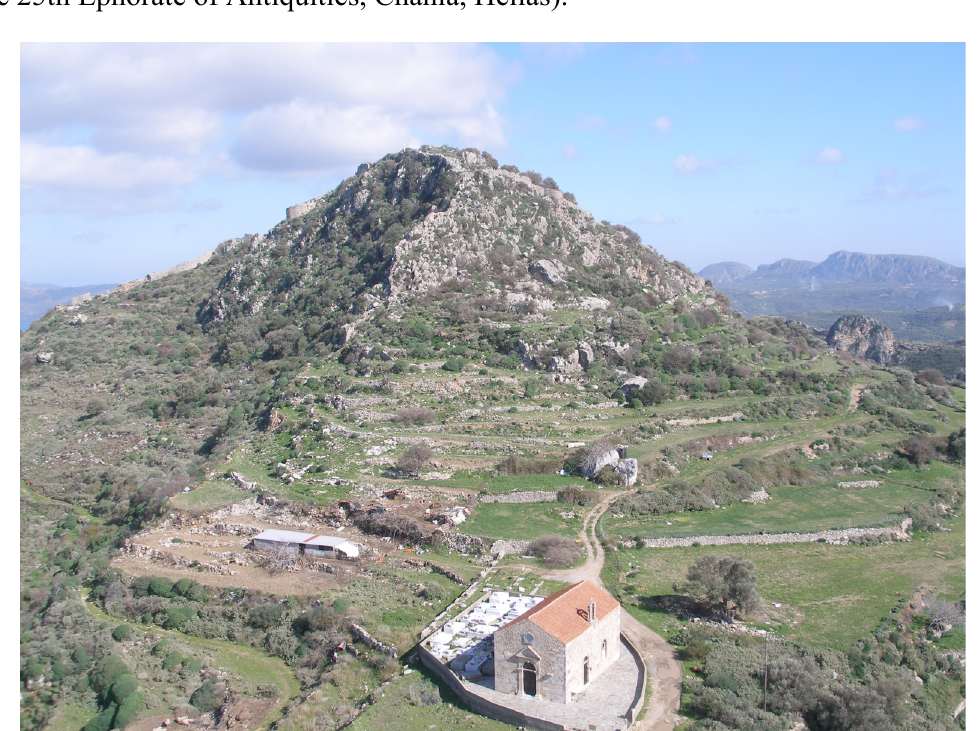
Figure 4. General view of ancient Polyrrhenia (with permission of D. Tzortzakis, archive of the 25th Ephorate of Antiquities, Chania,